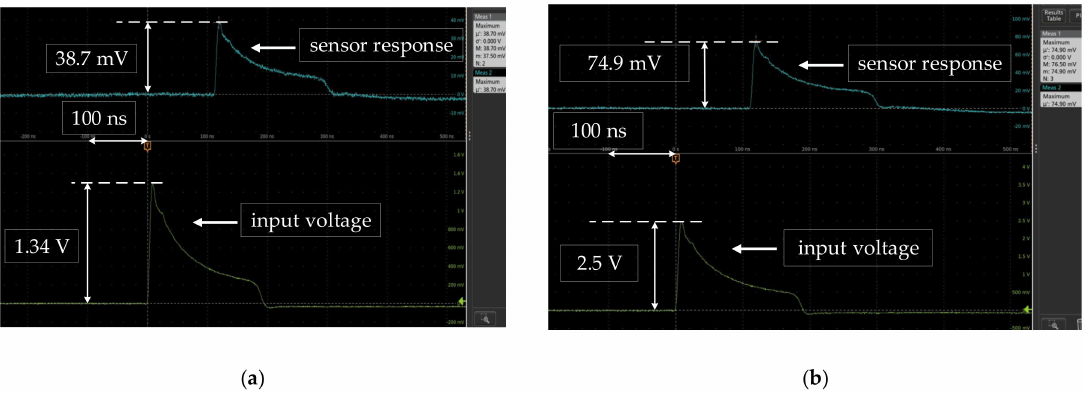
Figure 12. Time-domain response (100 ns/div): ( a ) E = 13 kV/m; ( b ) E = 25